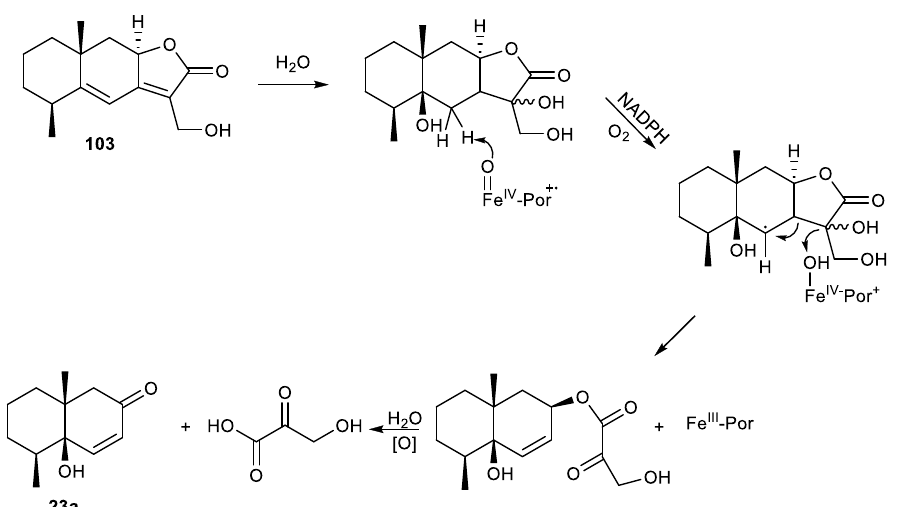
Figure 11. Proposed biosynthetic pathway to tri- nor -sesquiterpene by a special enzyme (adapted from Huang et al. 2010 [144]). from Huang et al. 2010 [144]).